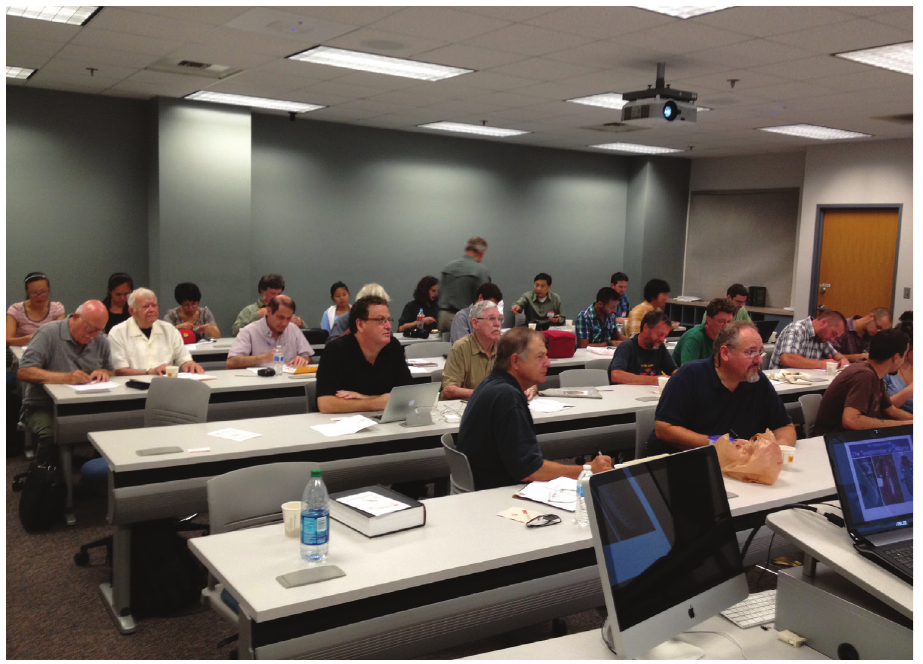
Figure 1. August 7th, before the first